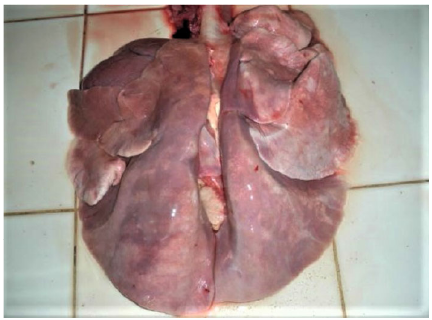
Figure 1: Gross appearance of ovine progressive pneumonia in the lung of a sheep. The a ff ected lung is enlarged and heavy and has no collapse, with rib impressions on the costal surfaces of the diaphragmatic lobes.